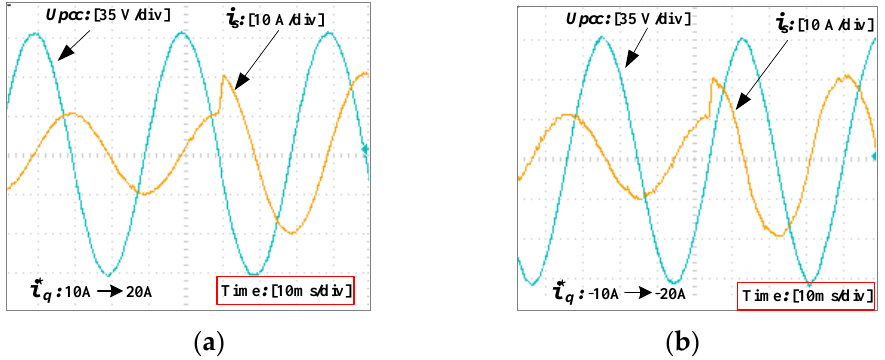
Figure 14. Waveforms of U PCC and i s with PLL. ( a ) Inductive reactive current; ( b ) capacitive reactive current.